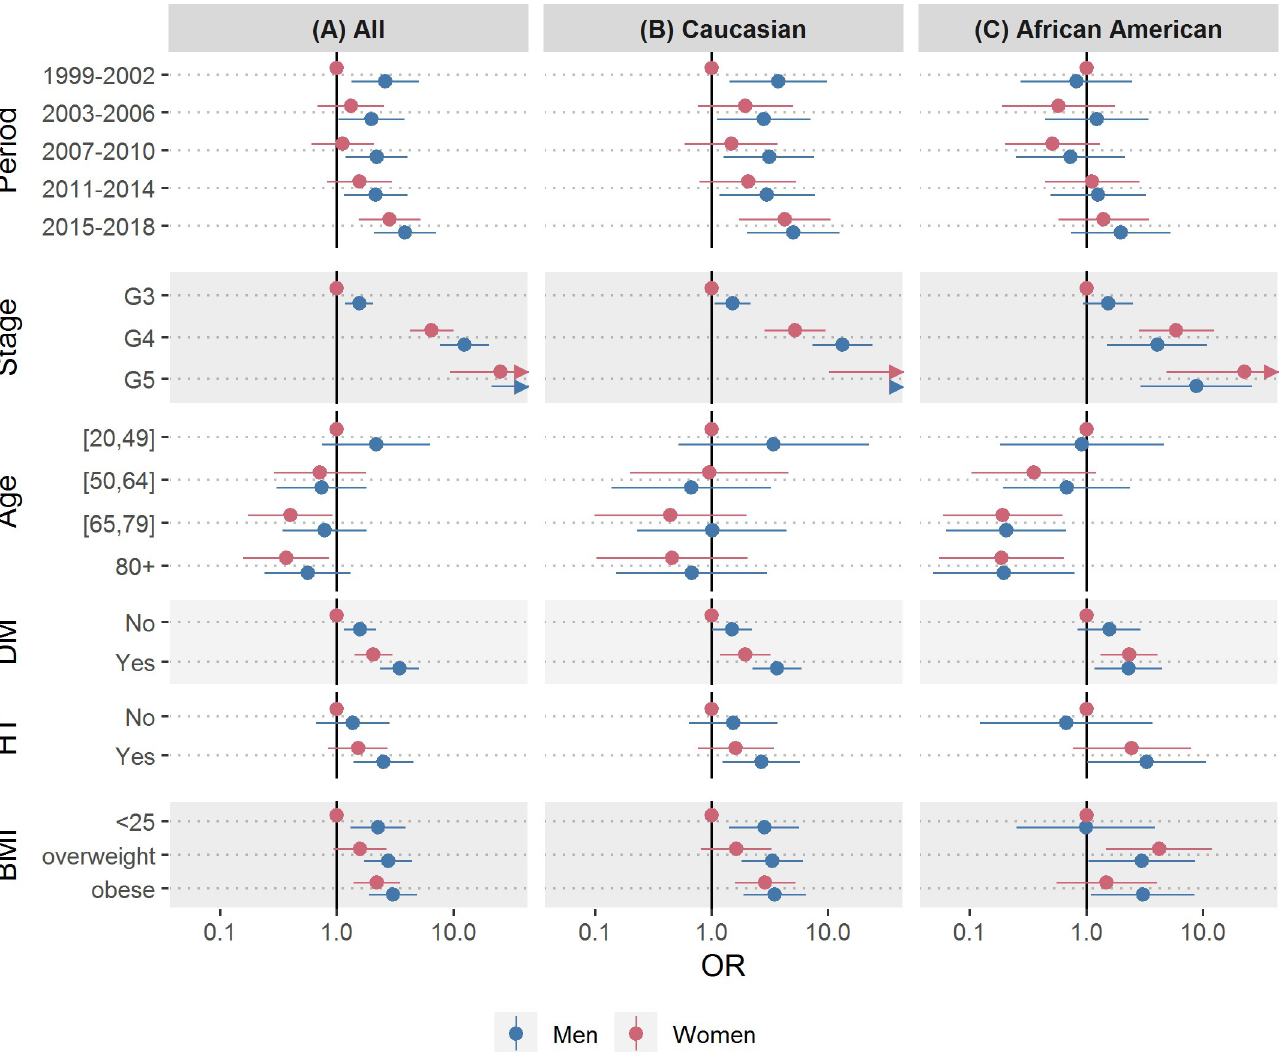
Fig 2. Association of chronic kidney disease awareness and patient characteristics. Association of chronic kidney disease (CKD) awareness by sex with period, CKD stage, age group, Diabetes Mellitus (DM), Hypertension (HT) and BMI in all NHANES participants (A), Caucasians (B) and African Americans (C), 1999– 2018; Odds ratios were adjusted for all other characteristics shown, odds ratios for all participants (A) were further adjusted for race/ethnicity. The numerical values for these odds ratios and 95% confidence intervals are shown in supporting information S3 Table .